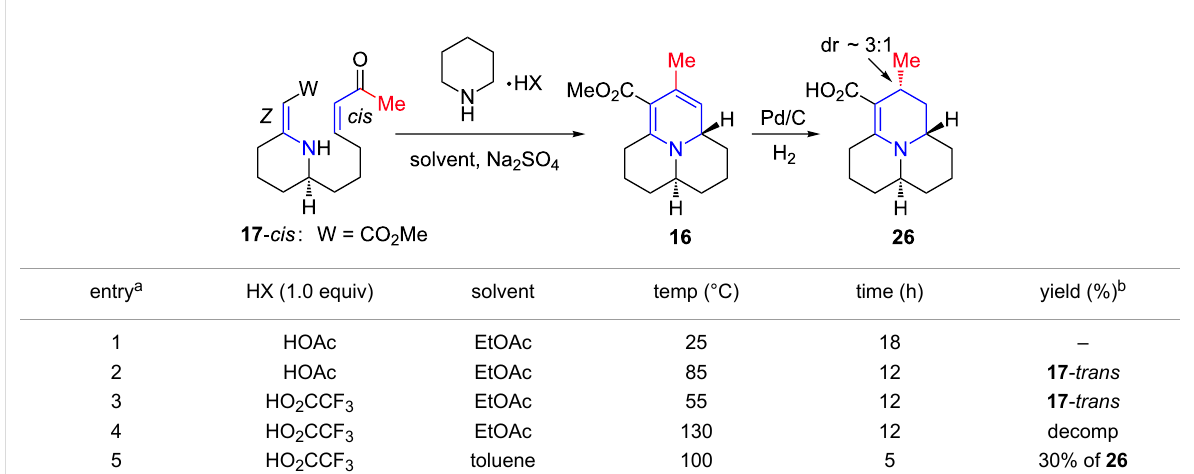
Table 3: Aza-[3 + 3] annulations of 17 - cis